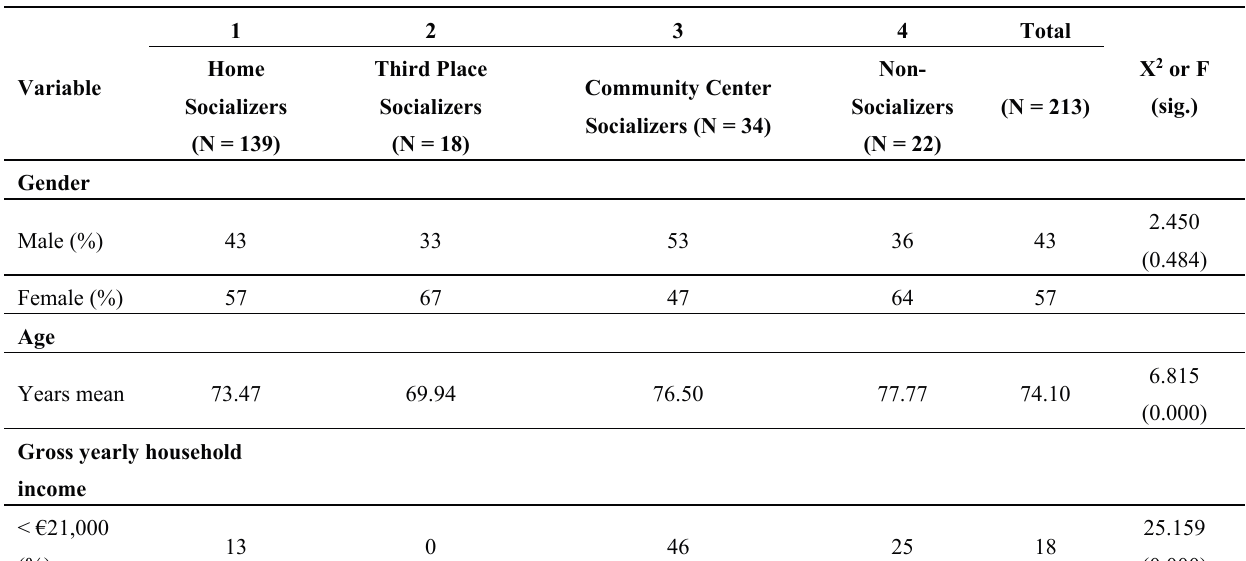
Table 5. Relationships between segments and personal, household and mobility characteristics.